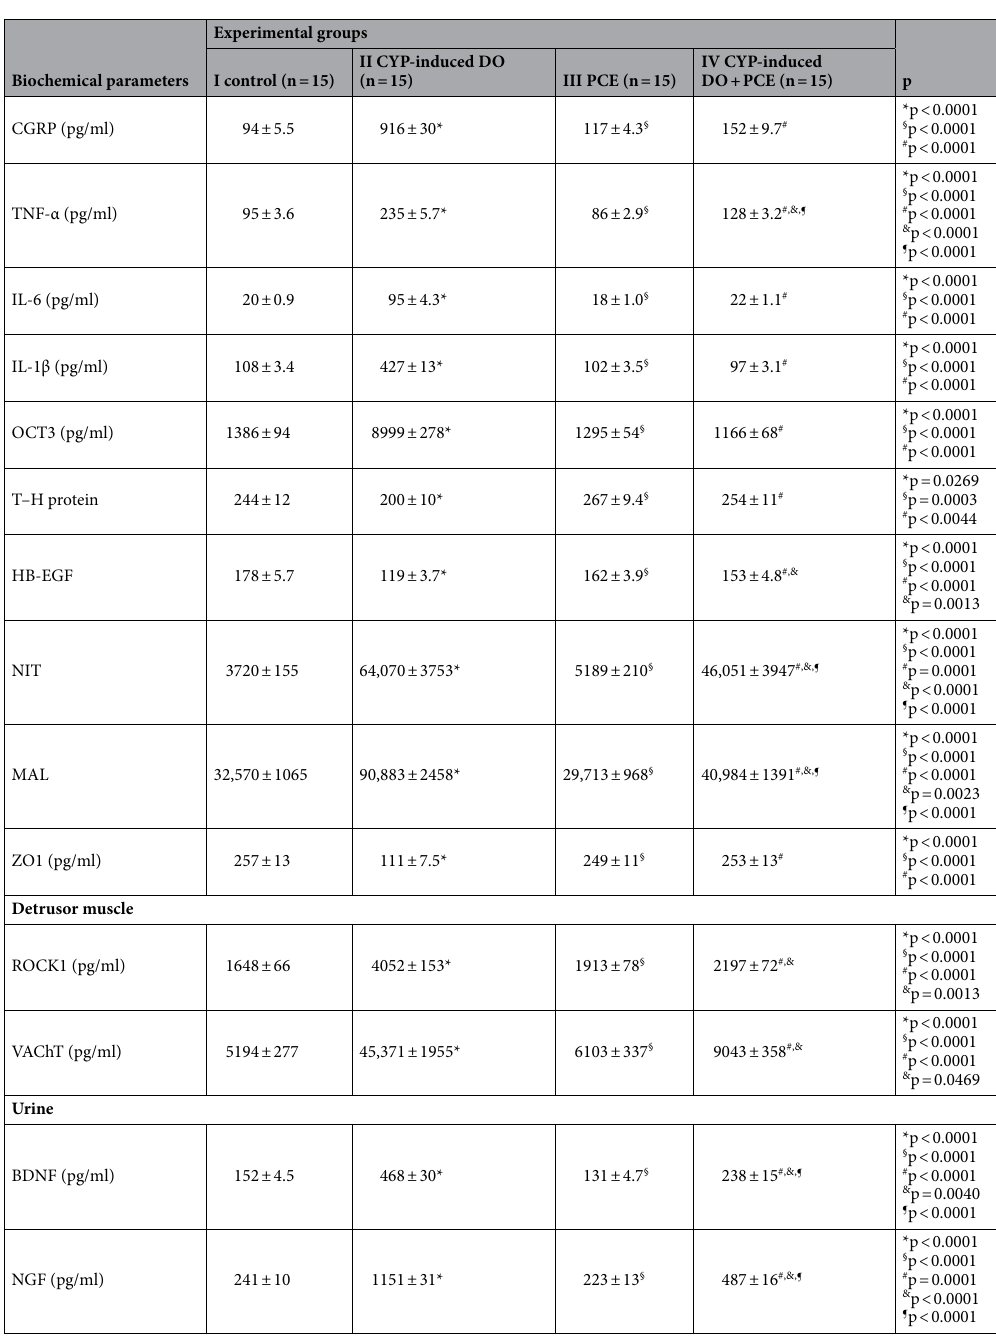
Table 3. Biochemical parameters of experimental groups. *Statistically significant differences between group I and group II (p ≤ 0.05), § Statistically significant differences between group II and group III (p ≤ 0.05), # Statistically significant differences between group II and group IV (p ≤ 0.05), & Statistically significant differences between group I and group IV (p ≤ 0.05), ¶ Statistically significant differences between group III and group IV (p ≤